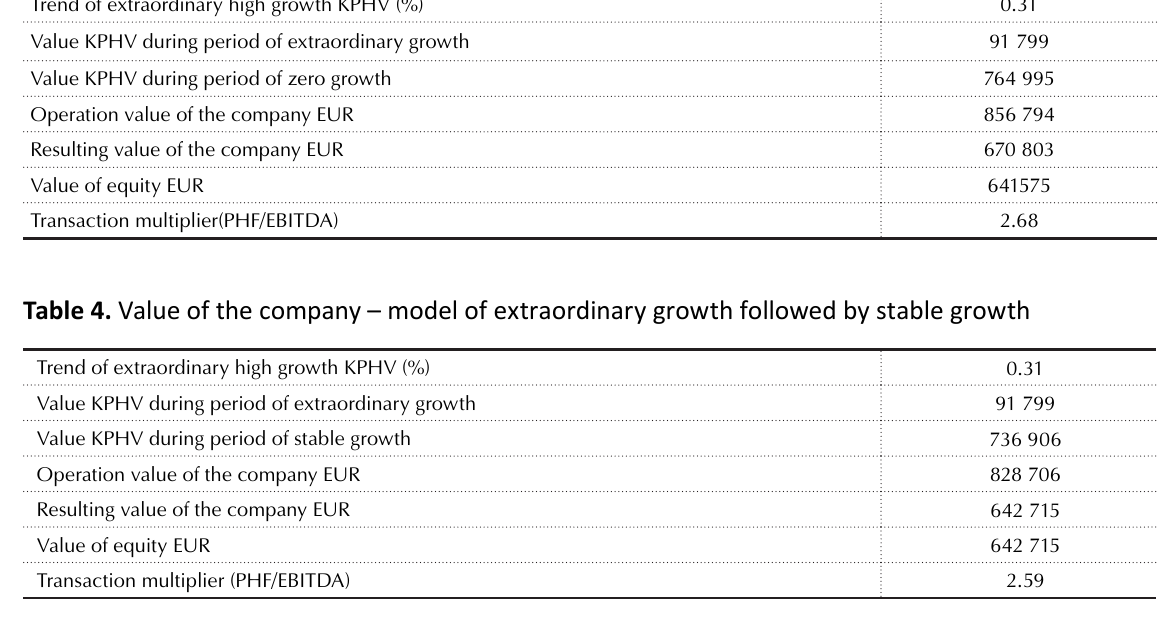
Table 3. Value of the company – model of extraordinary growth followed by zero growth Trend of extraordinary high growth KPHV (%)